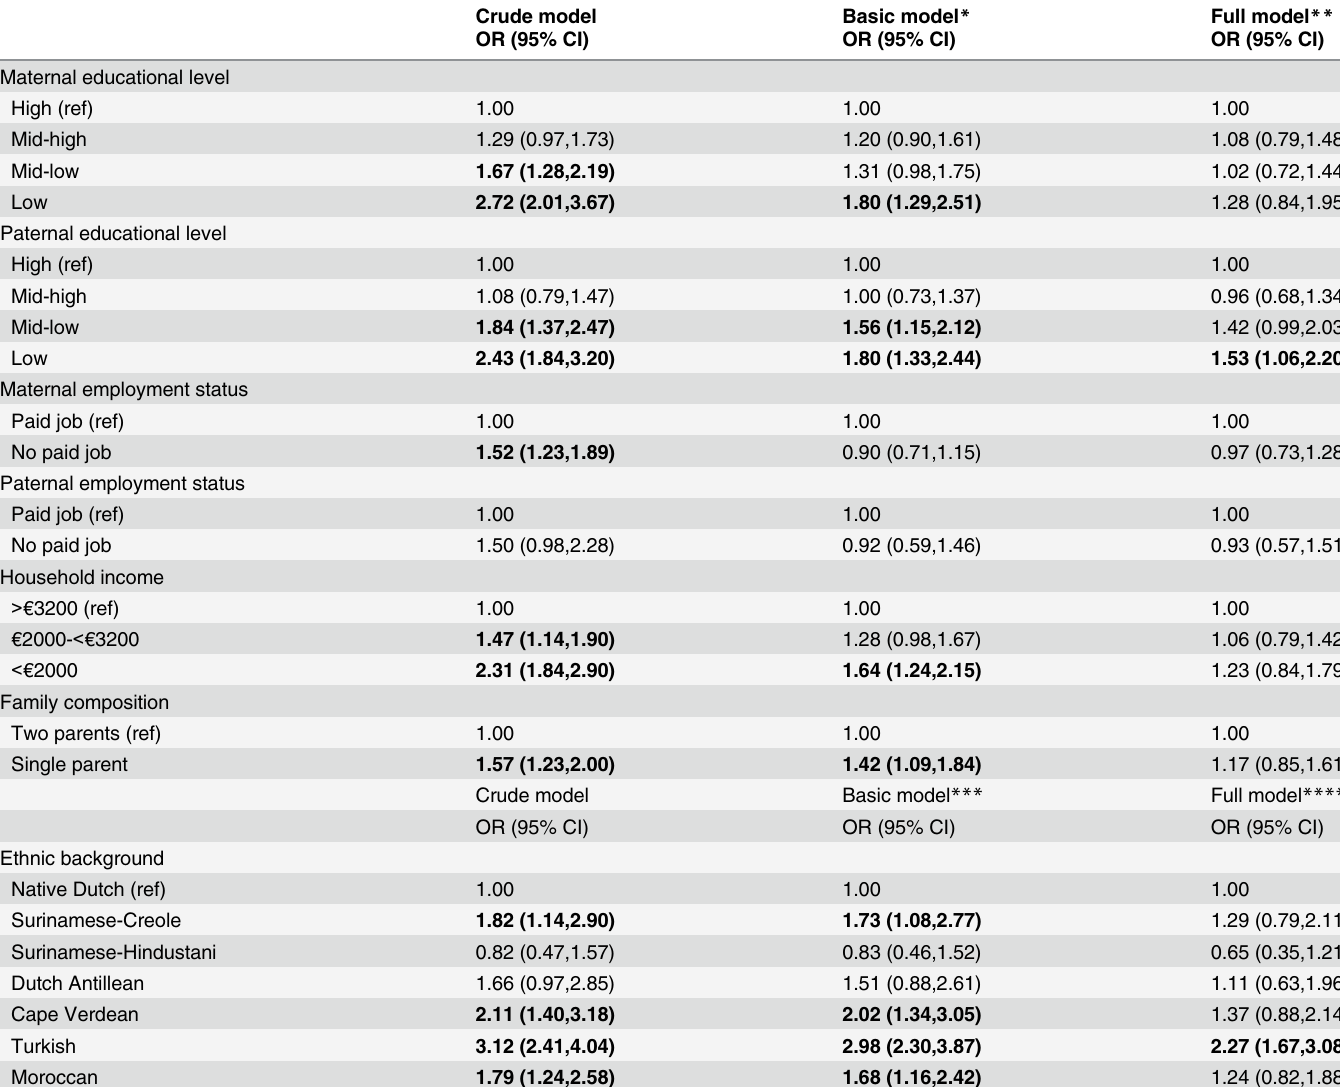
Table 4. Associations of family socioeconomic position and ethnic background with lunch skipping at age 6 years (n = 4593).